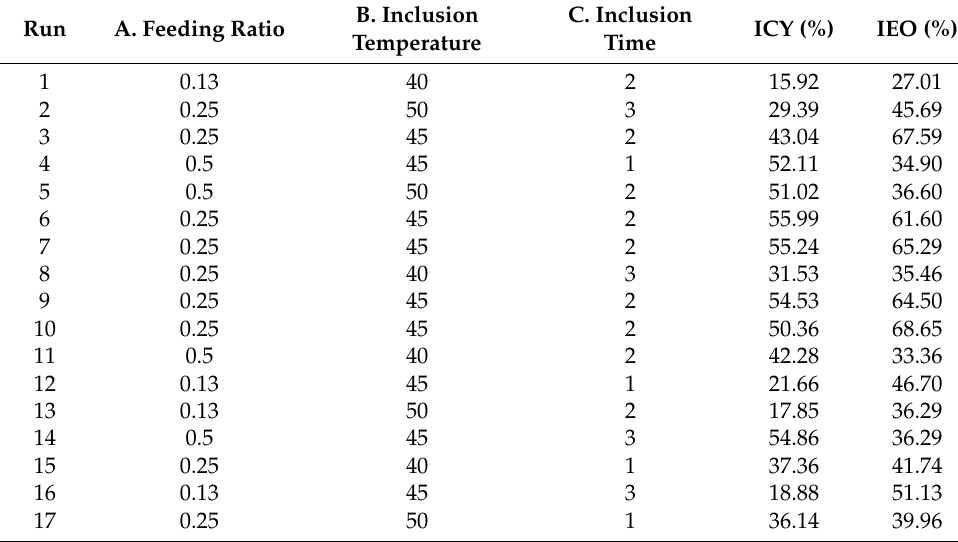
Table 3. Experimental design and